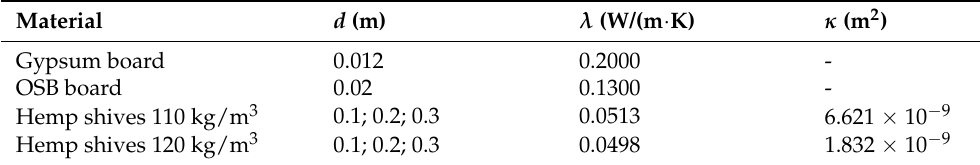
Table 4. Physical properties of materials used in the simulation.